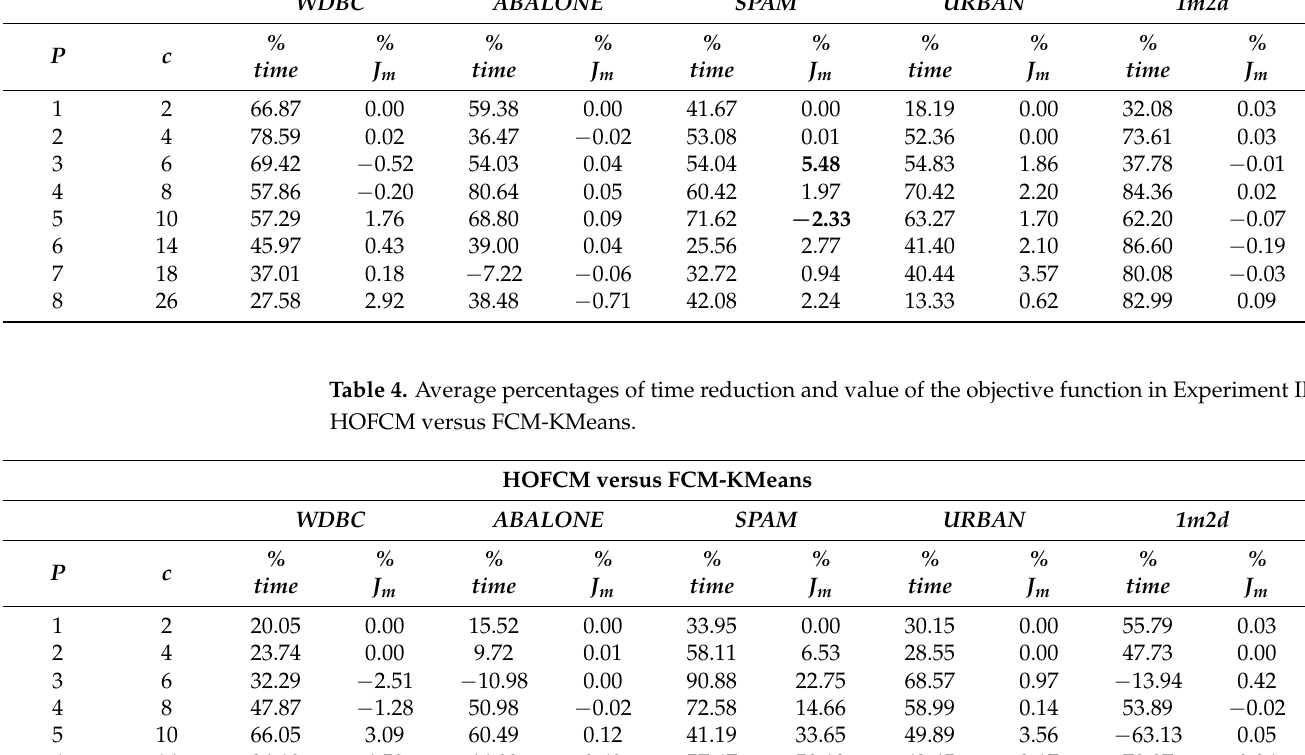
Table 3. Average percentages of time reduction and value of the objective function in Experiment II; HOFCM versus FCM++.